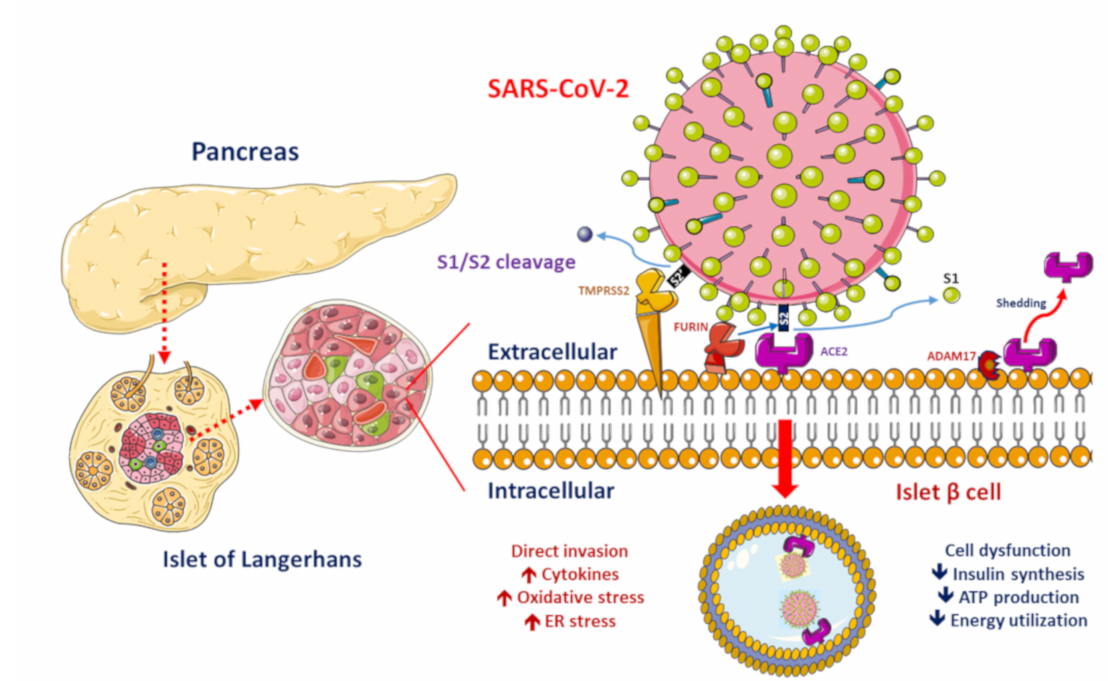
Figure 1. Proposed functions of pancreatic β -cell molecules for interaction with severe acute respiratory syndrome coronavirus 2